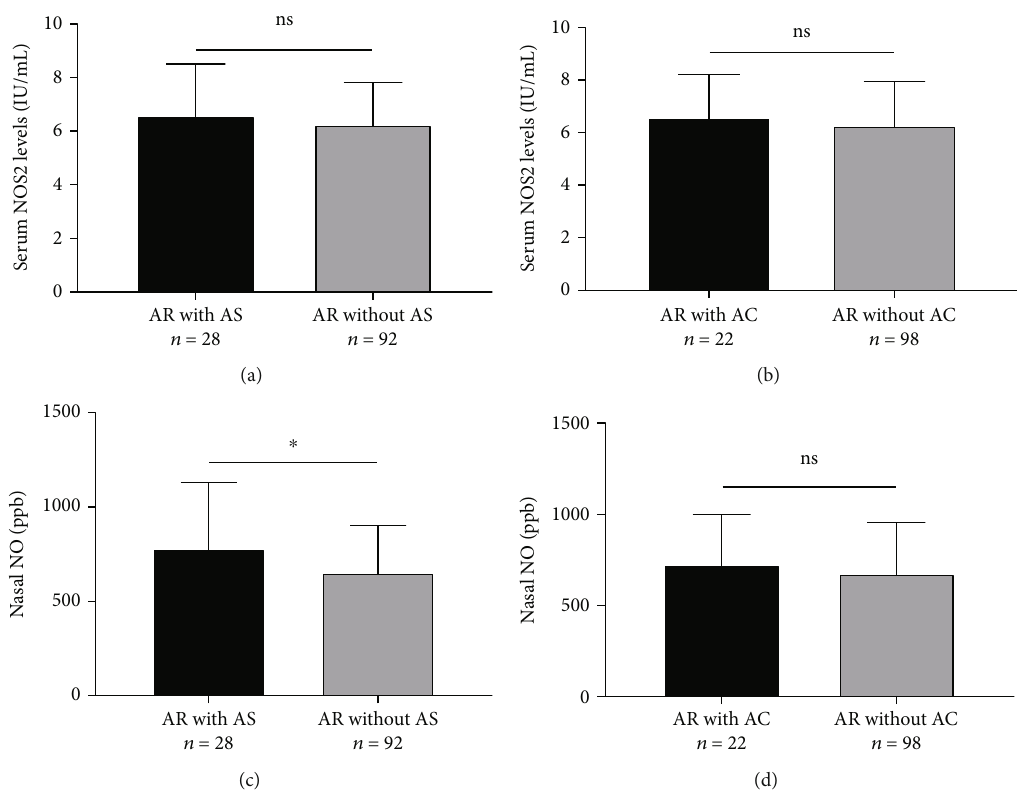
Figure 2: Expression levels of serum NOS2 and nNO in the AR subgroup. (a) Serum NOS2 levels were not di ff erent in AR with AS group and AR without AS group. (b) Similarly, serum concentrations of NOS2 were also not signi fi cantly di ff erent in the AR with AC group and AR without AC group. (c) nNO levels were signi fi cantly elevated in AR with AS group compared to the AR without AS group. (d) nNO levels were not signi fi cantly di ff erent in the AR with AC group and AR without AC group. NOS2: inducible nitric oxide synthase; nNO: nasal nitric oxide; AR: allergic rhinitis; AS: allergic asthma; AC: allergic conjunctivitis; ns: no signi fi cance, ∗ P < 0 : 05